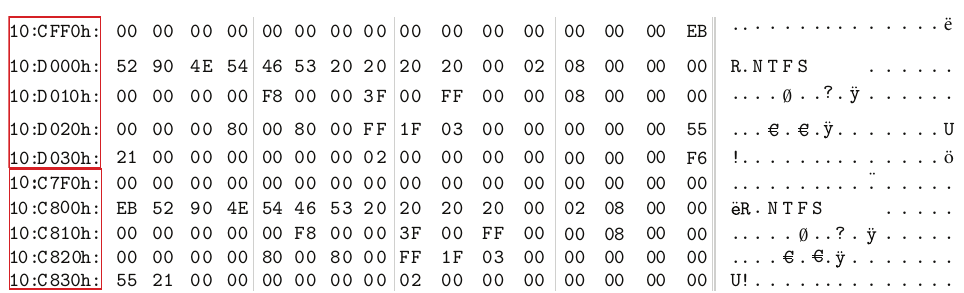
Figure 4: Comparison of offsets for the same file: top, original HDD; bottom, acquisition